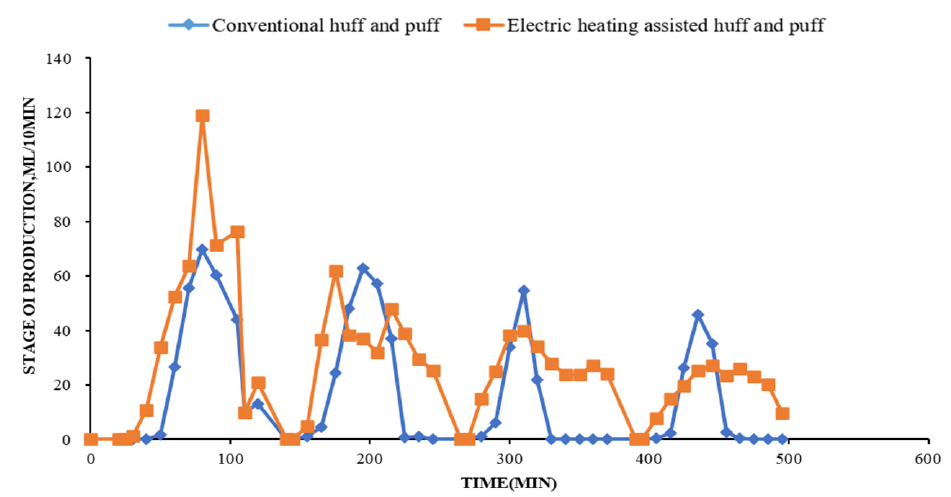
10 of 14 Figure 7. The comparison of the temperature field at the end of the second cycle production phase. 4.3. Comparison of Production Characteristics and Analysis of Porous Flow Mechanism (1) Comparative characteristics of conventional CSS and E-CSS Figure 8 shows the comparison of the oil production rate for conventional CSS and E-CSS. From Figure 8, the comparison of oil production speeds shows that conventional CSS had a rapid decline in production during the production phase, while the use of electric heating effectively slowed down the decline in production. The statistics of four cycles of conventional CSS were 281 mL, 237 mL, 118 mL, 113 mL, and the total oil pro- duction was 749 mL; that of E-CSS was 460 mL, 253 mL, 280 mL, and 197 mL, a total of